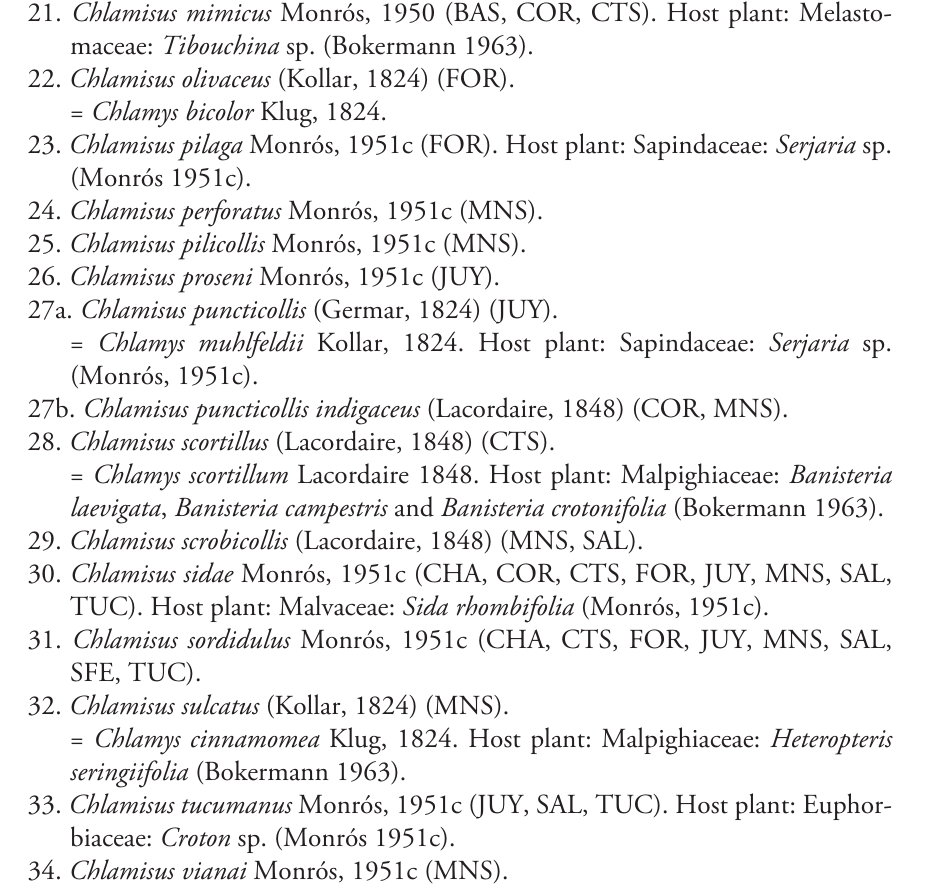
Fig. 30 Exema Lacordaire, 1848: 844; Jacoby 1908: 278; Karren 1966: 647; Chamorro-Lacayo and Konstantinov 2009: